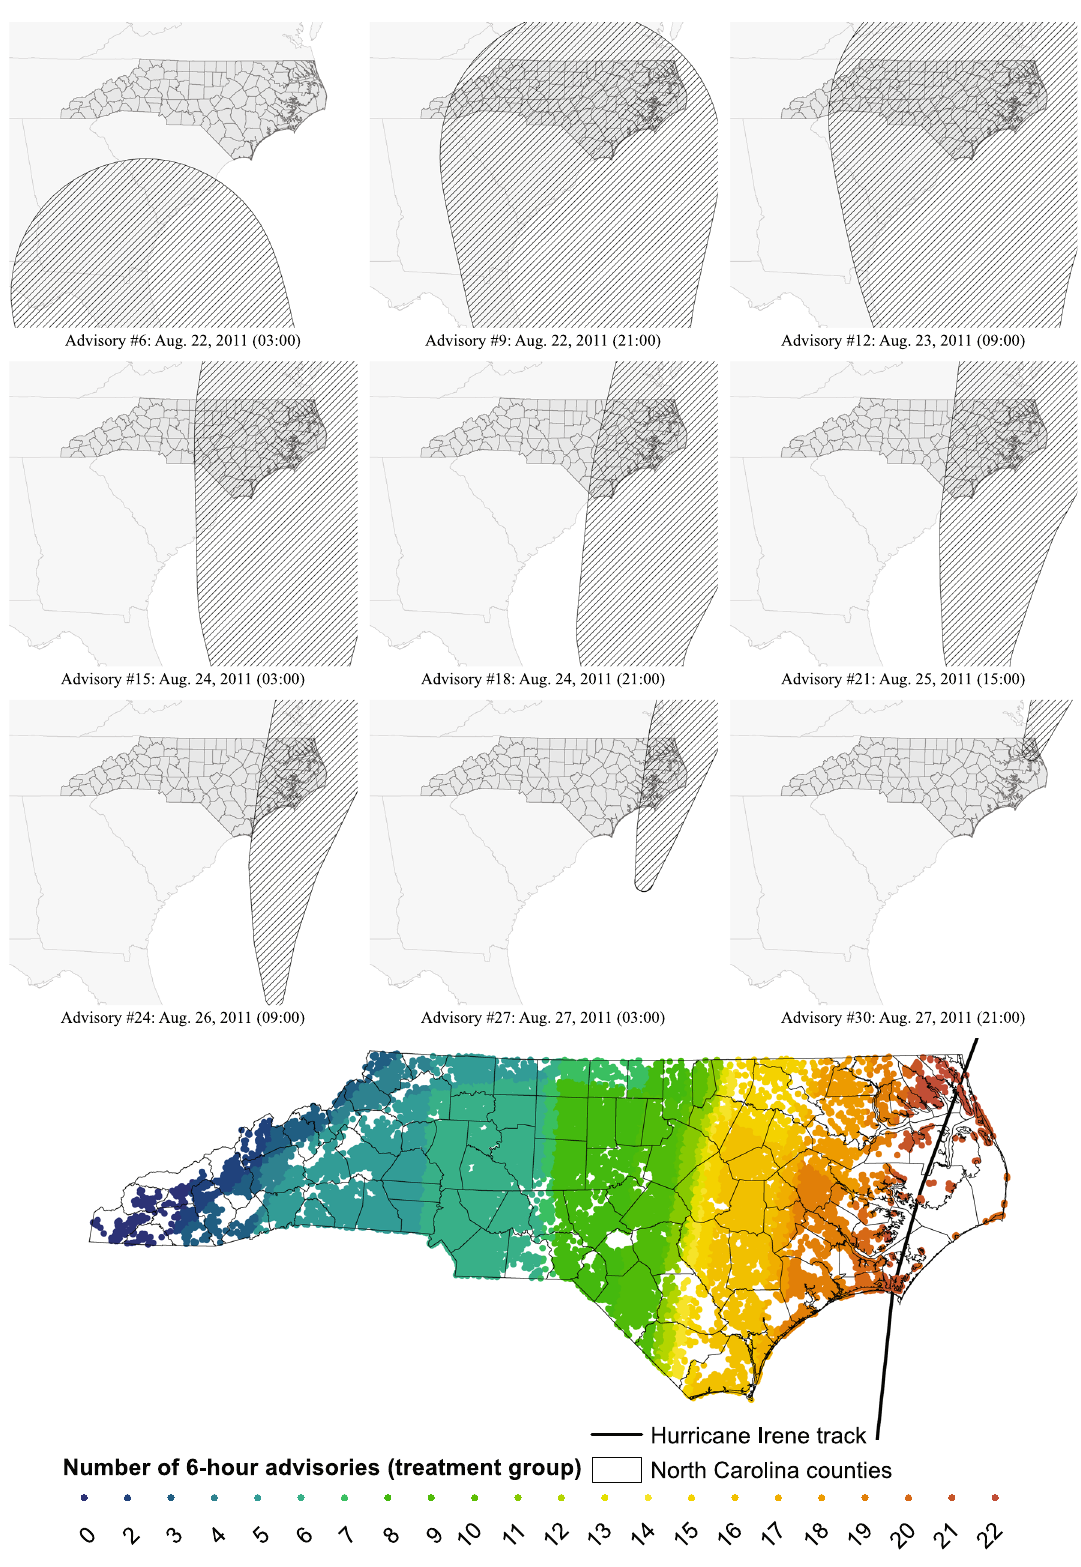
Fig. 3 | Total number of 6-h advisories (a sample of which are shown here) experiencedwithintheConeofUncertaintyfortheresidentialaddressofeach womanwithin HurricaneIrene ’ streatment sample. The underlying rawdataare